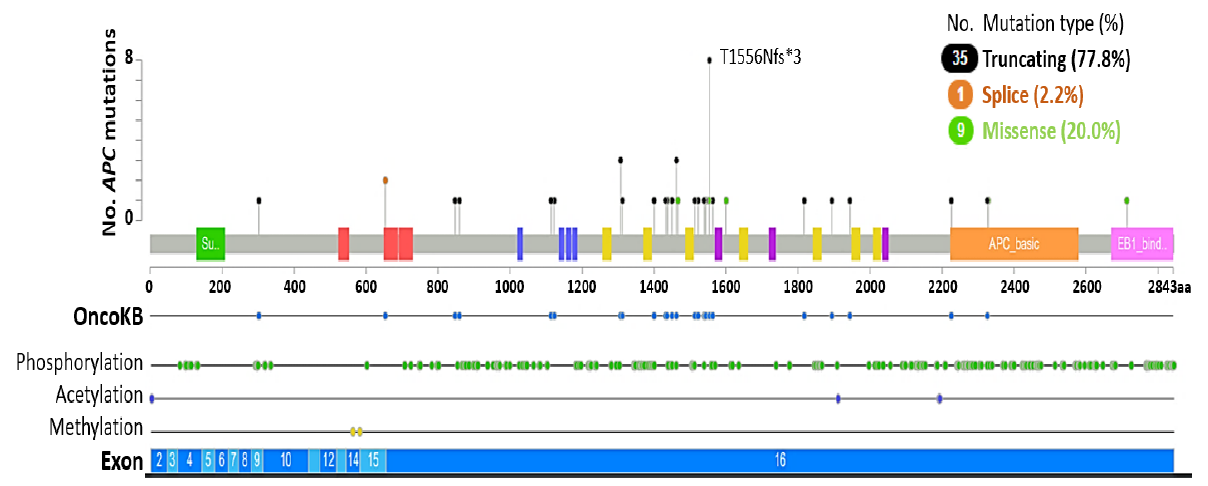
Figure 3. APC somatic and germline mutations in prostate cancer. Diagram indicates APC mutation frequency in relation to exons and post-translational modifications. OncoKB indicates alterations that are likely to be oncogenic ( n = 36/45, 80%). Data sourced from The Cancer Genome Atlas (TCGA) Firehose Legacy (primary: n = 492) [66] and the SUC2/PFC International Dream Team (metastatic: n = 444) [64] prostate adenocarcinoma datasets using cBioPortal [68,69] (Table S6). Germline mutations: 2/45 (4.44%). Somatic mutations: 37/45 (82.22%). Unknown mutational status: 6/45 (13.33%).